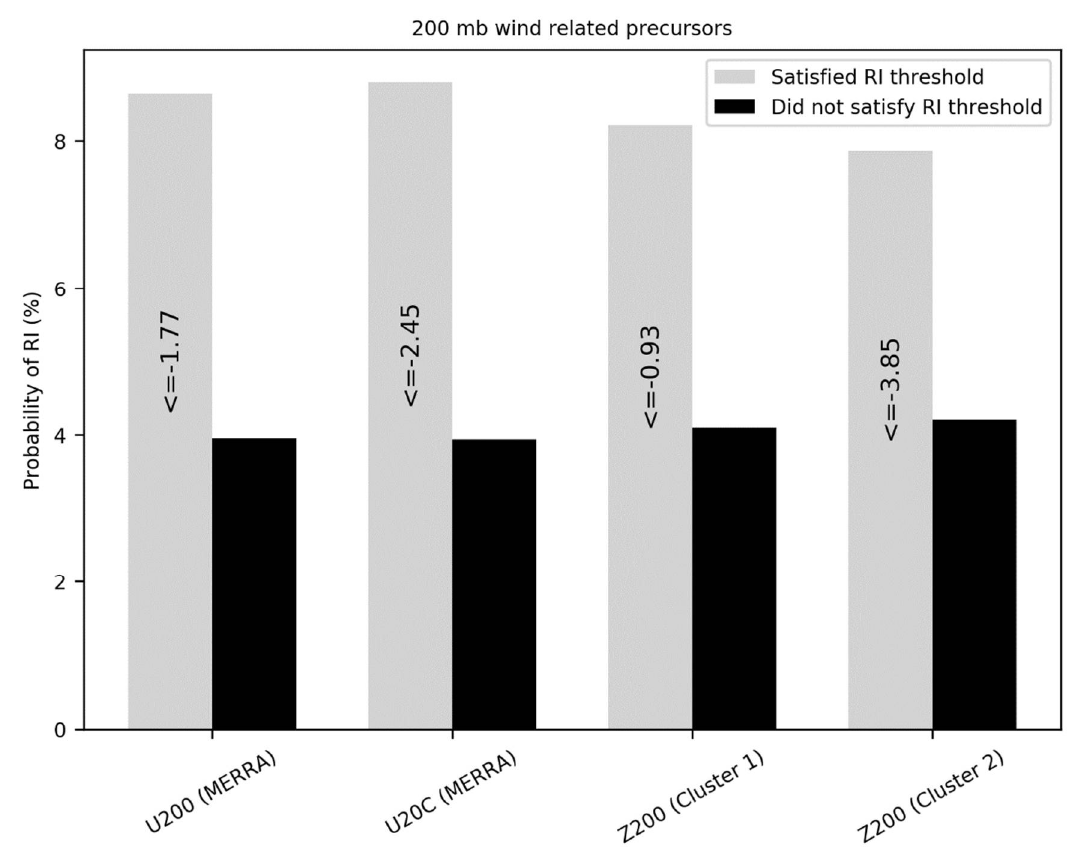
Figure 6. The probability of RI when the 200 hPa wind related precursors were satisfied for the RI and non-RI samples. The RI thresholds for each of the predictors are also presented in m/s.